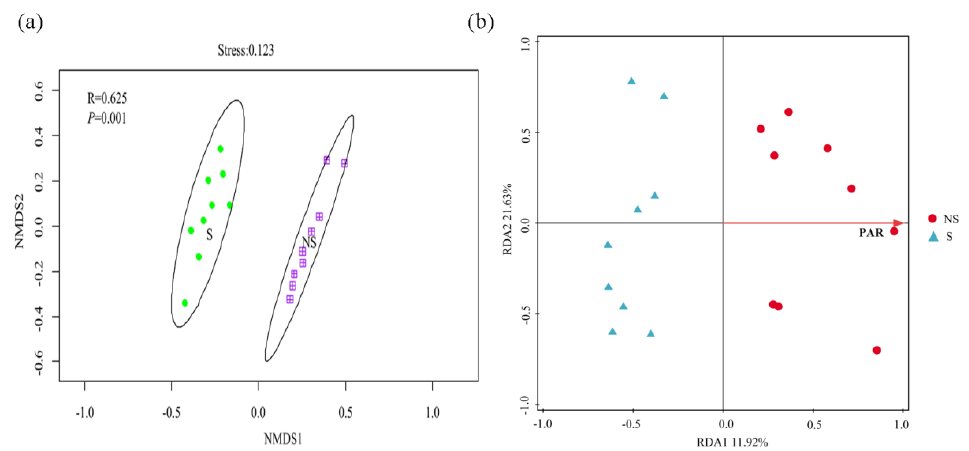
Figure 9. Beta diversity of protistan communities based on Bray–Curtis distance (on OTU level) analyzed by NMDS plots ( a ) and redundancy analysis of the correlation between environmental factors and community structure of protists ( b ).